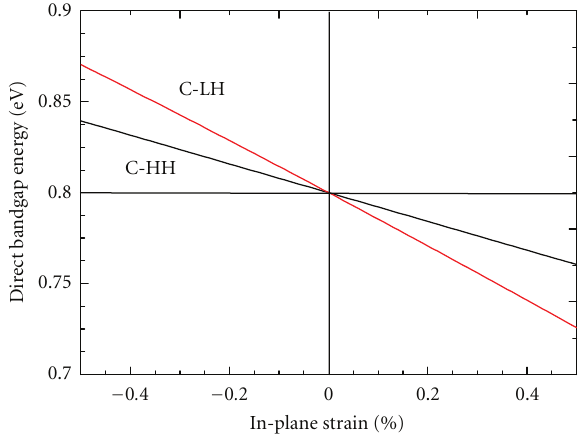
Figure 6: Direct bandgap energies of Ge as a function of in-plane biaxial